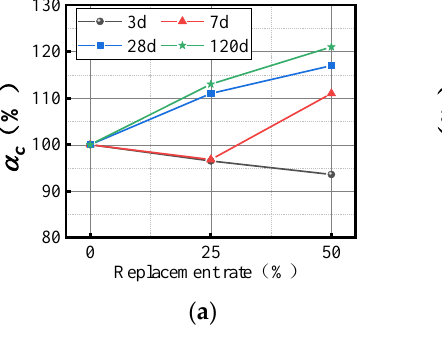
( c ) Figure 9. Development coefficient of strength for each category: ( a ) β c ; ( b ) β t ;( c ) β F. From Figure 9, it can be seen that the β of all types of specimens after tailings incor- poration are smaller than the β of specimens without tailings incorporation at the early stages (3 d, 7 d). There is an opposite trend (greater strength development for IOTC) for the curing age of 120 d, and the magnitude increases with the increase of IOT incorpora- tion. In Figure 9a, the β c for the 50% iron tailings mix is smaller at three days, while the β c for the 25% iron tailings mix is smaller at seven days, and they are all smaller than those of specimens without tailings at the same age. At 120 days, the β c for the 50% iron tailings mix is larger than that for the 25% mix. In Figure 9b, we can notice that β t decreases with the increase of IOT incorporation at early ages (3 d, 7 d), and for the 50% admixture at 120